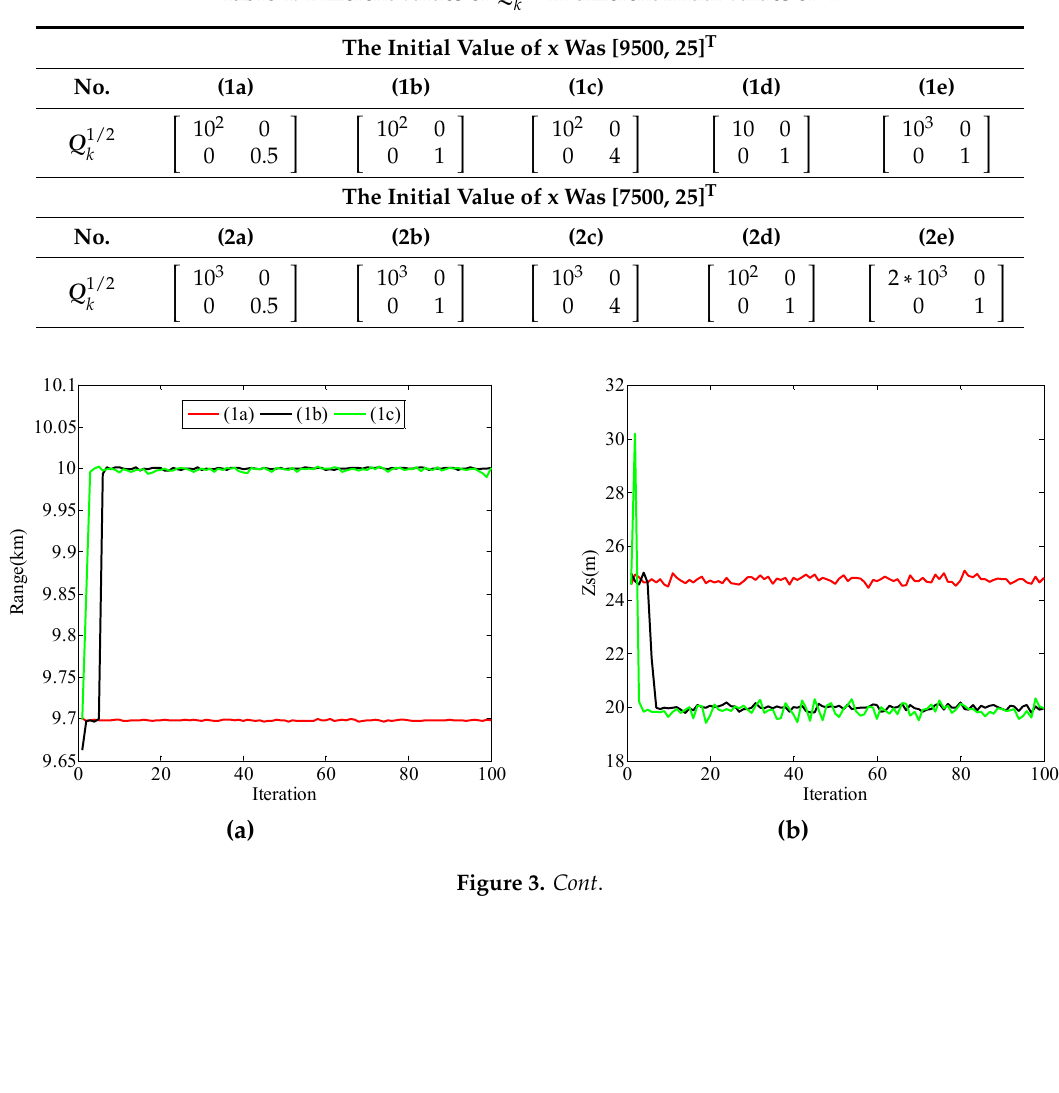
Table 4. Different values of 1 2 Table 4. Di ff erent values of Q 1/2